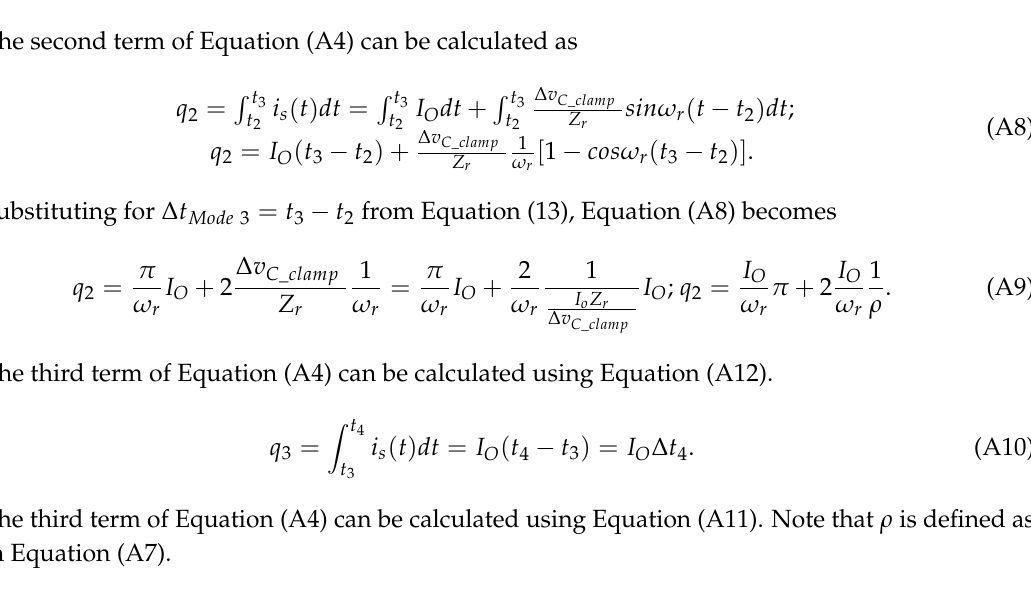
Figure A2. Secondary current and clamp capacitor voltage waveforms.